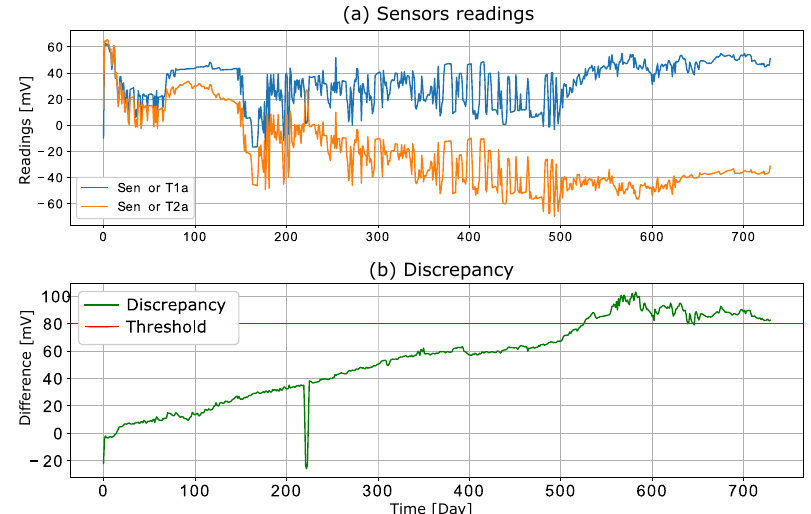
Figure 3. Data generated from the publicly available dataset [14]: ( a ) Sensor measurements averaged per day for two sensors; ( b ) discrepancy